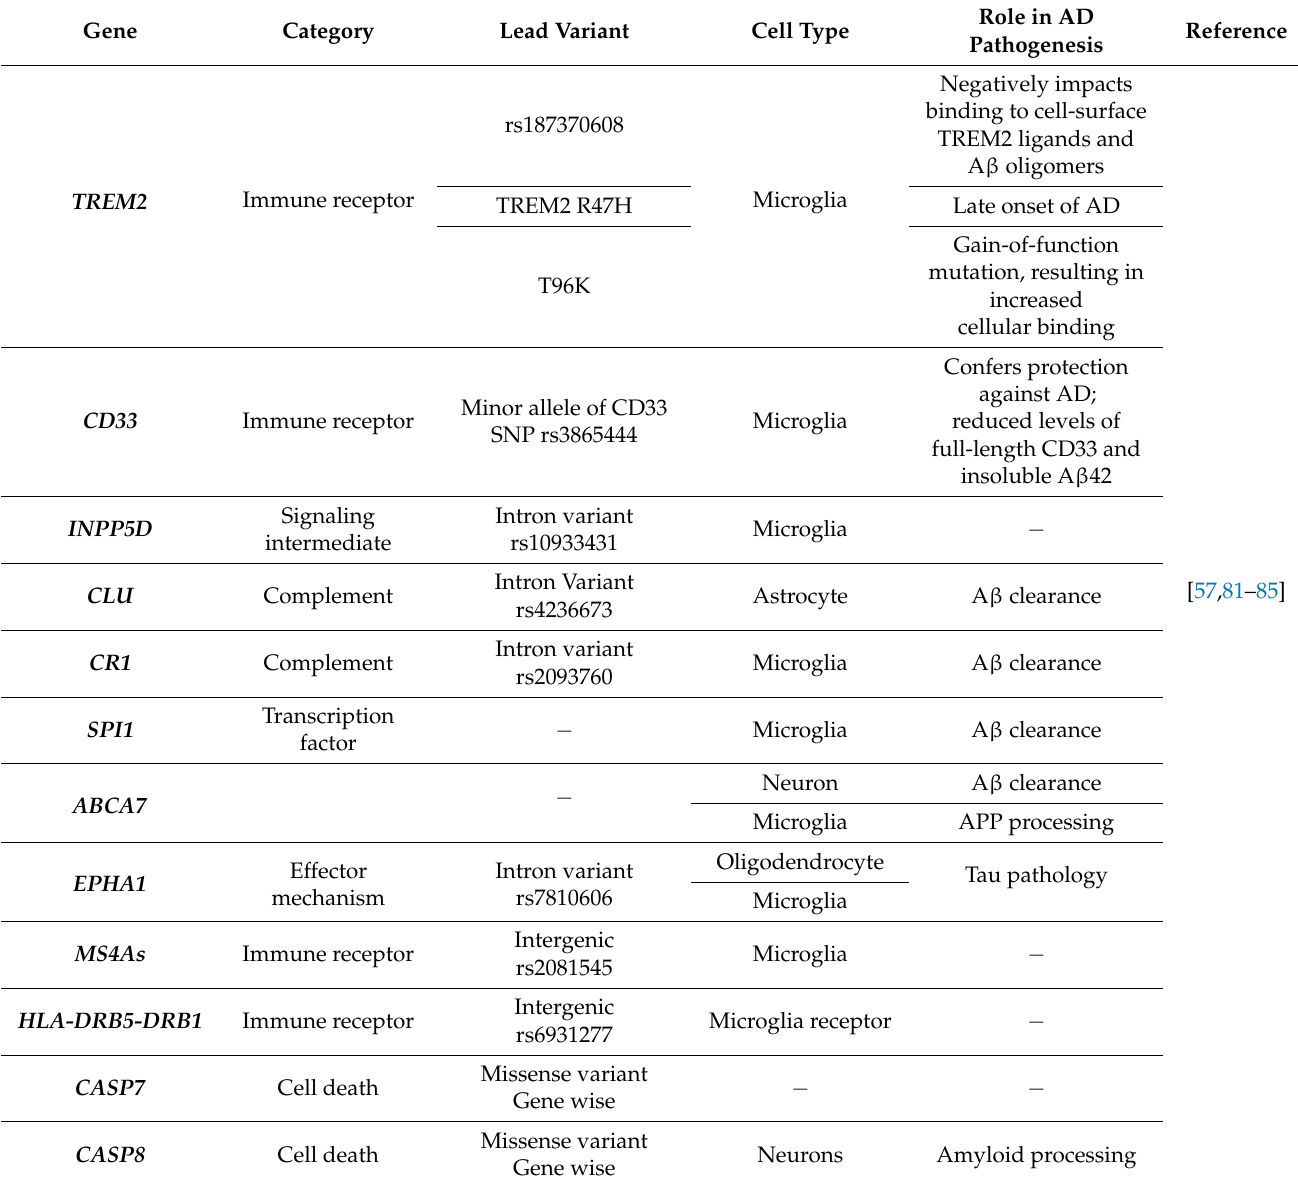
Table 1. Summary of immune genes that have mutations associated with